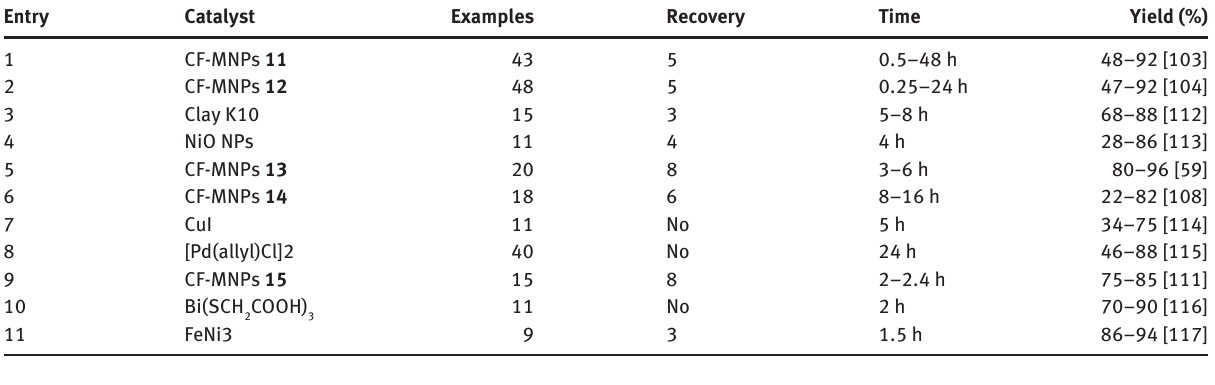
Table 7: Comparison of the activity of CF-MNPs catalysts with other reported catalysts in synthesis of pyrroles (entries 1–4), imidazols and oxazoles (entries 5–8), and thiazolidinones (entries